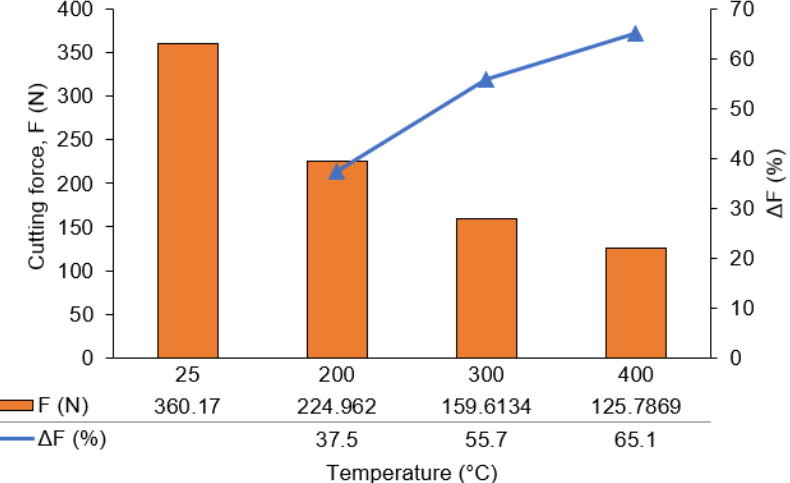
Figure 8. The mean cutting forces and the corresponding reductions observed during machining at various temperatures.